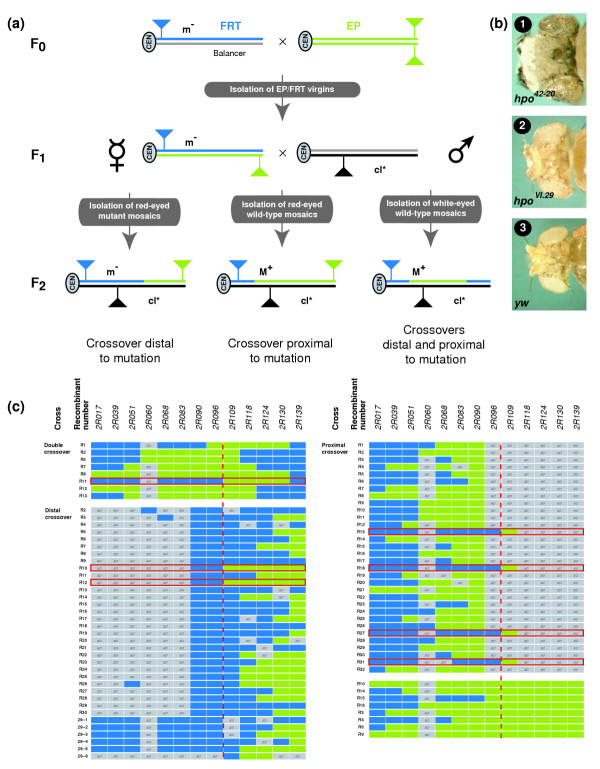
FLP mapping in Drosophila. (a) Crossing scheme used to map mutations generated in the FRT background and recombined with an EP line. The different classes of recombinants recovered in the F2 generation are shown. (b) Big head phenotypes of the hippo null allele hpo42-20 (1) and the VI.29 mutation (2). A wild-type control is shown in (3). (c) FLP mapping of the VI.29 mutation on chromosome 2R. Analysis of the different classes of recombinants places the mutation between markers 2R096 and 2R109 (dashed red line). Informative recombinants are boxed in red. ND, not determined or no data as a result of PCR reaction failure.